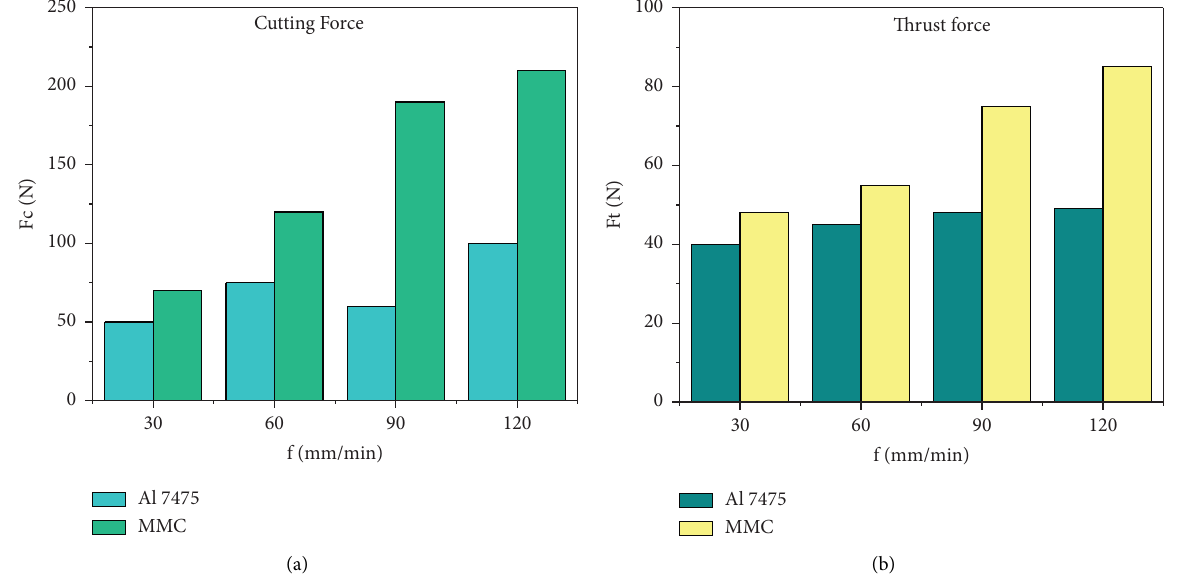
Figure 3: Comparison of forces with feed rate (at V � 90m/min and a